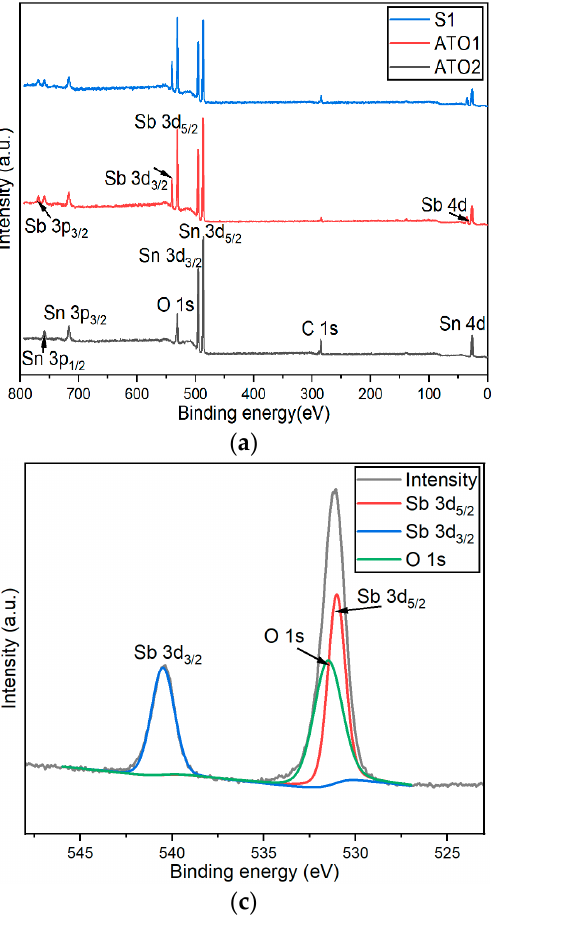
Figure 4. XPS spectra of S1 and ATO1 and ATO2: ( a ) survey spectrum, ( b ) Sn 3d spectrum, and ( c ) Sb 3d spectrum of ATO2. ( d ) XPS valence band of the three samples.